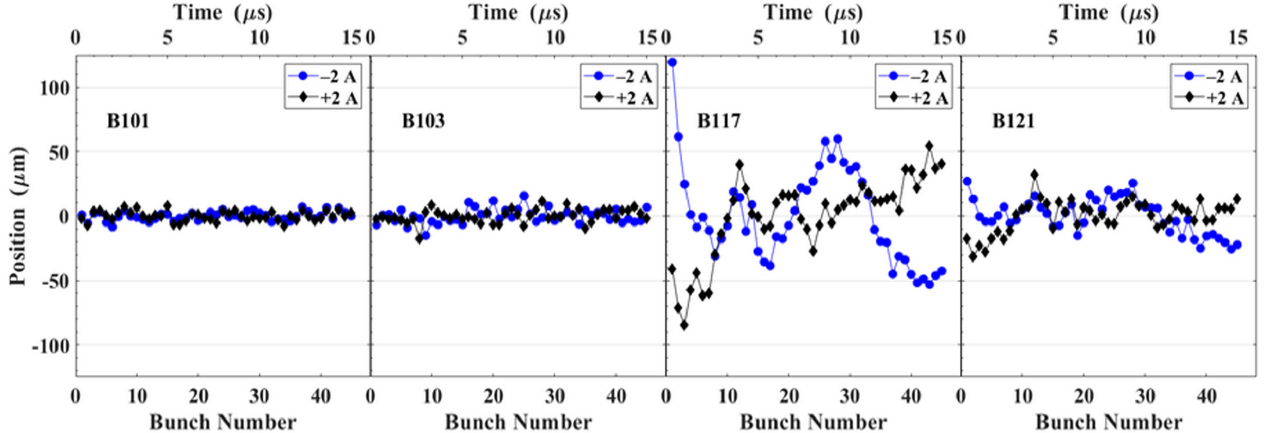
FIG. 8. Examples of the variation of the beam vertical centroids bunch by bunch for 50 micropulses and 500 pC = b at B101, B103, B117, and B121 for V103 settings of (cid:1) 2 A ( (cid:1) 4 mrad) from the reference. These were 100-shot averages to show the potential 100-kHz oscillation effects generated in CC2 when beam is off axis and observed downstream at B117 and B121. Note that no oscillations are observed in the upstream B101 and B103 locations.